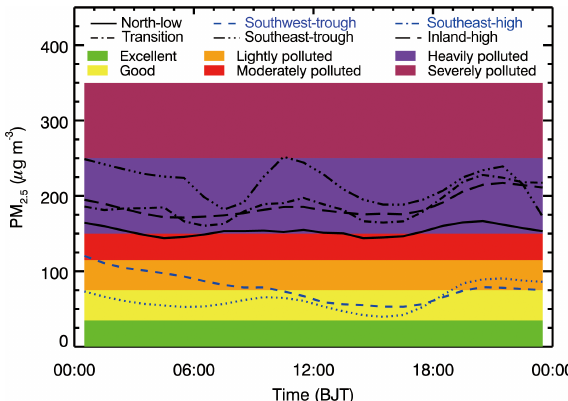
Figure 5. Diurnal cycle of observed PM 2 . 5 mass concentrations av- eraged over 33 monitoring sites in the Guanzhong basin under the six synoptic categories during the wintertime of 2013.